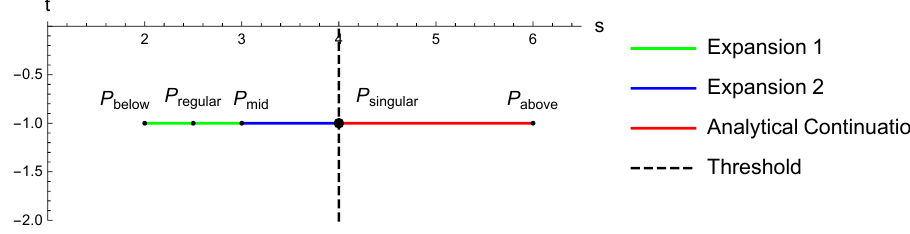
Figure 3 . The interval along which we plot the basis B , is covered by three expansions obtained by patching and analytical